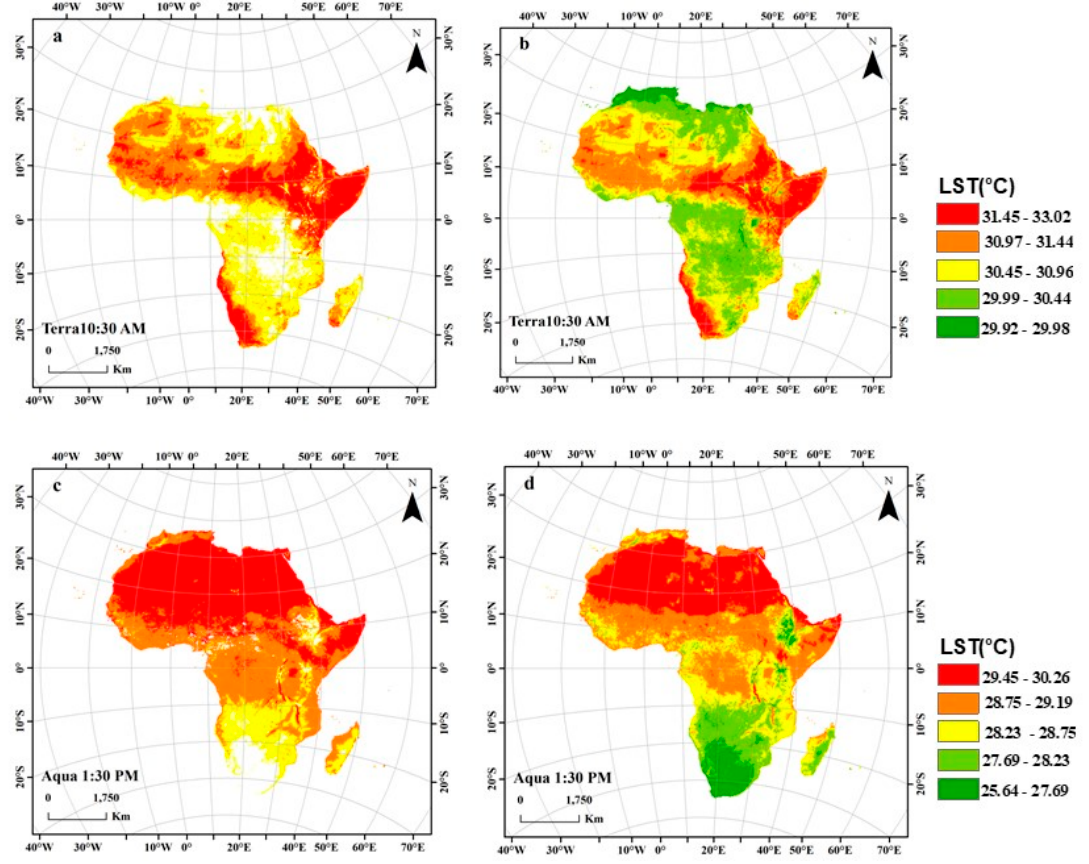
Figure 3. Spatial distribution of reconstructed missing values for February 2017 and August 2017 from the Terra and Aqua satellites: ( a , c ) original LST data; ( b , d ) data after interpolation (areas of invalid data are shown in white).